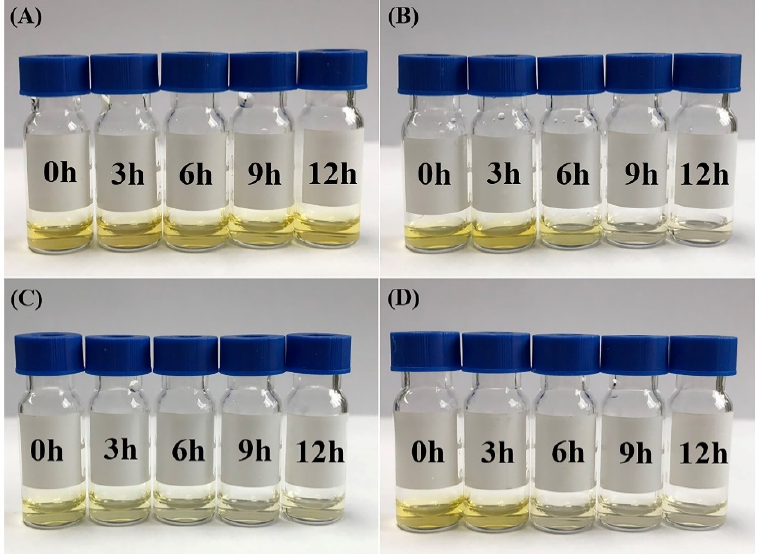
Figure 6. The color change of the supernatant obtained from curcumin- β -CD degradation by various concentrations of β -CGTase and AG at different times. ( A ) Curcumin- β -CD (10 mg/mL) without enzyme; ( B ) curcumin- β -CD (10 mg/mL) with β -CGTase (0.90 U) and AG (0.90 U); ( C ) curcumin- β -CD (3 mg/mL) with β -CGTase (0.90 U) and AG (0.90 U); and ( D ) curcumin- β -CD (10 mg/mL) with β -CGTase (1.35 U) and AG (0.90 U).